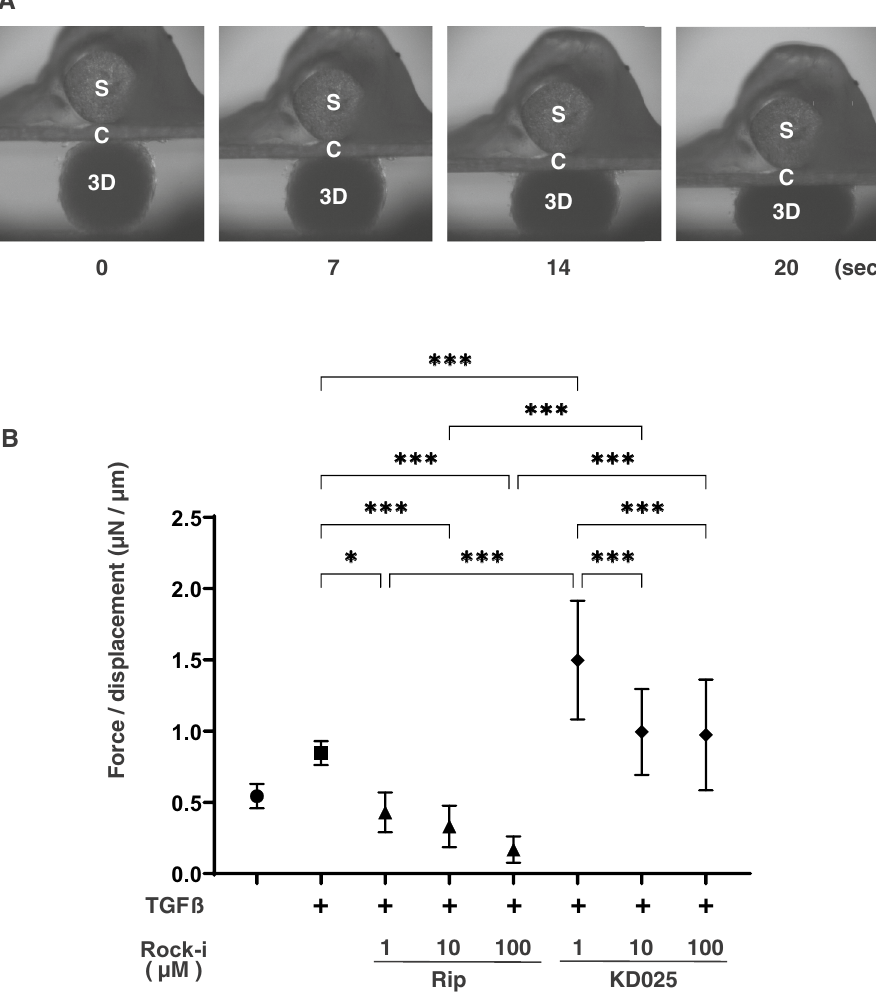
Figure 3. Physical solidity of 3D HTM sphenoids. The panel A shows representative photos demonstrating the micro-squeezer analysis at different time points; 0, 7, 14 or 20 ( S pressure sensor, C compression plate, 3D 3D sphenoid) measured over a period of 20 s. The force (μN) required to induce a 50% deformity of every single out of 15–20 freshly prepared 3D HTM sphenoids (non-treated control) and those treated by 5 ng/ml TGFβ2 in the absence or presence of 1, 10 or 100 μM ROCK-i, ripasudil (Rip) or KD025 were measured, and force/ displacement (μN/μm) values were plotted in Panel B. * P < 0.05, *** P < 0.005 (ANOVA followed by a Tukey’s multiple comparison